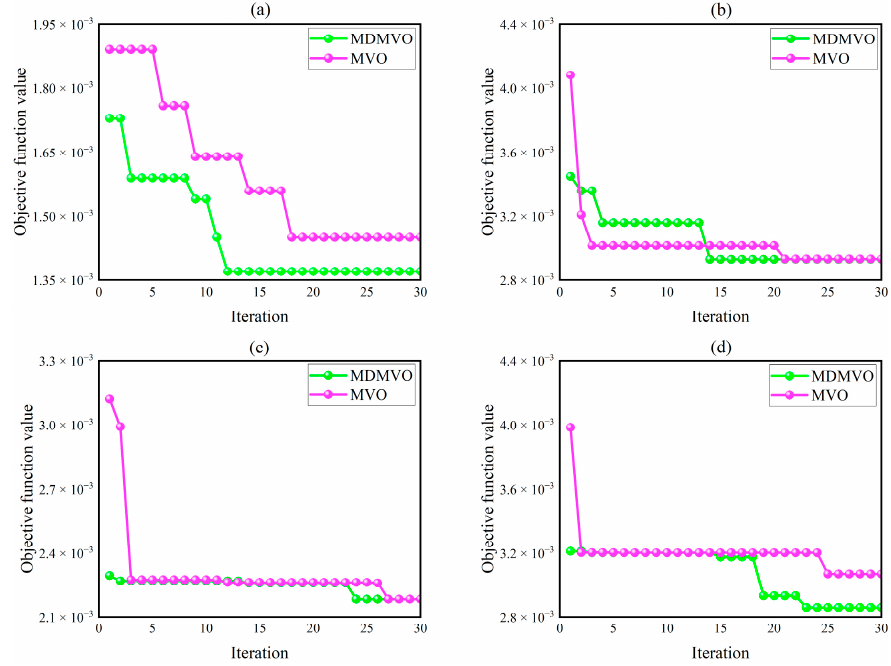
Figure 23. Comparison of MCKD parameters optimized by MDMVO and MVO: ( a ) extraction of outer race fault, ( b ) inner race fault extraction from compound fault signal, ( c ) outer race fault extraction from compound fault signal, ( d ) roller fault extraction from compound fault signal.